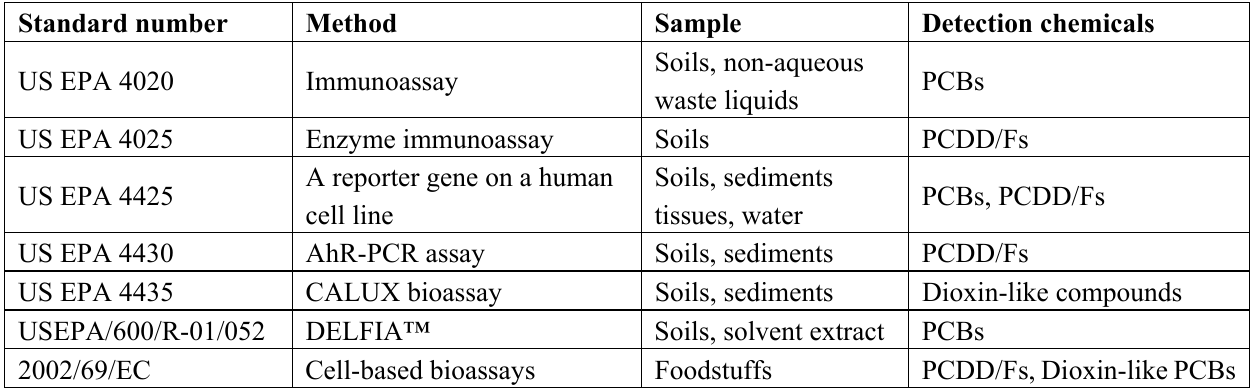
Table 2. List of standard bioassays for detection of